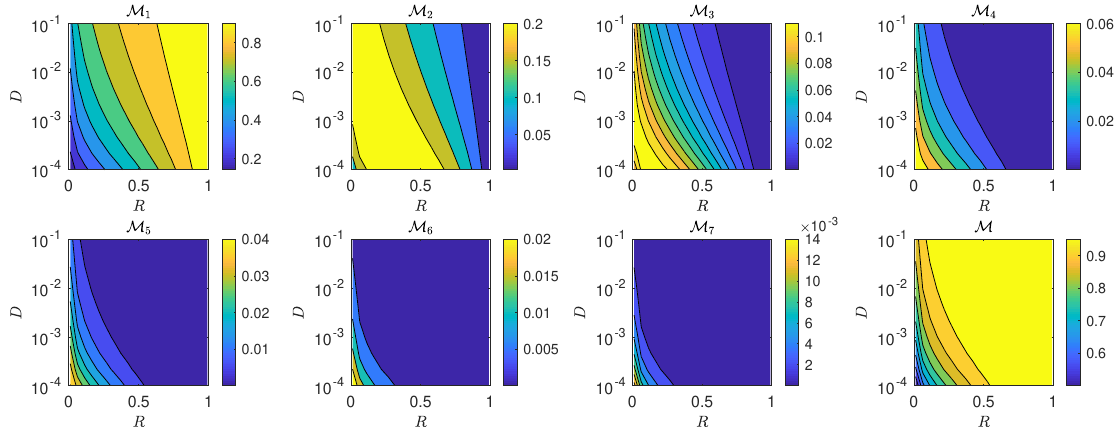
Figure 9. Night-by-night and total mating probabilities under constant calling. Note the different likelihood scales for each panel. Similar to Figure7, intermediate-quality moths (medium { R , D } ) display relatively large mating likelihoods M (cid:96) on the second and successive nights.